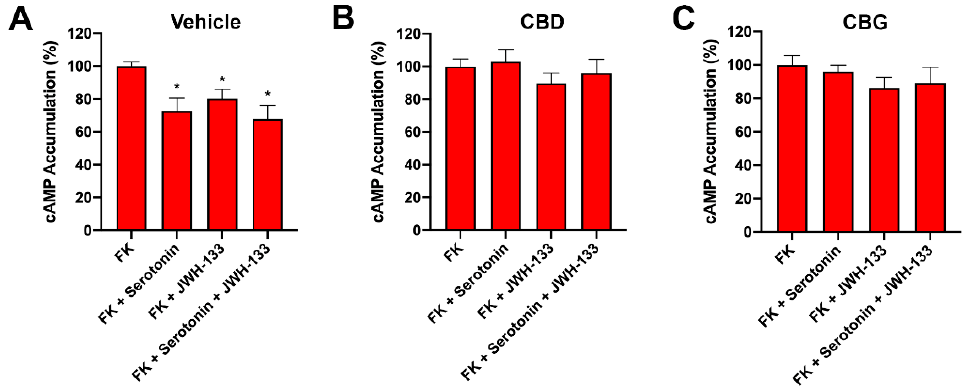
Figure 5. Effect CBD or CBG on the receptor functionality in GOD primary striatal neurons. Mouse primary striatal neurons were treated with vehicle ( A ), 200 nM of CBD ( B ), or 200 nM of CBG ( C ) for 30 min prior GOD for 4 h. Then, neurons were treated with selective agonists, 200 nM JWH-133, or 200 nM serotonin. cAMP levels were expressed as a percentage versus 0.5 µ M forskolin treatment. Values are the mean ± S.E.M. of 8 different experiments performed in triplicate. One-way ANOVA followed by Dunnett’s multiple comparison post hoc tests were used for statistical analysis. * p < 0.05 versus forskolin treatment.